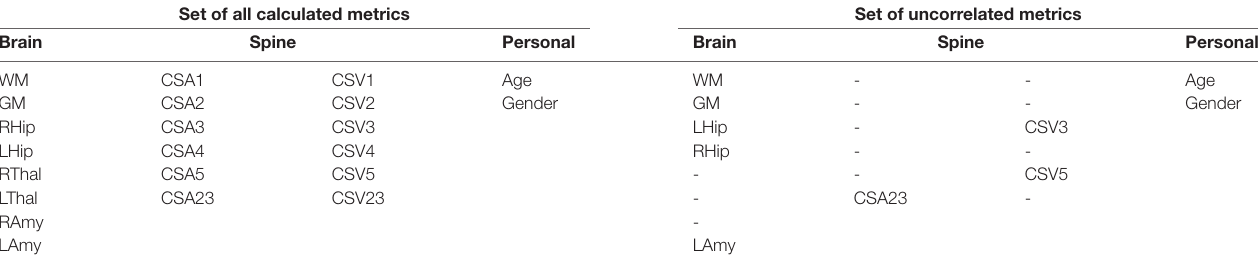
TABLE 4 | Cerebral and spinal cord morphometric metrics. Set of all calculated metrics Set of uncorrelated metrics